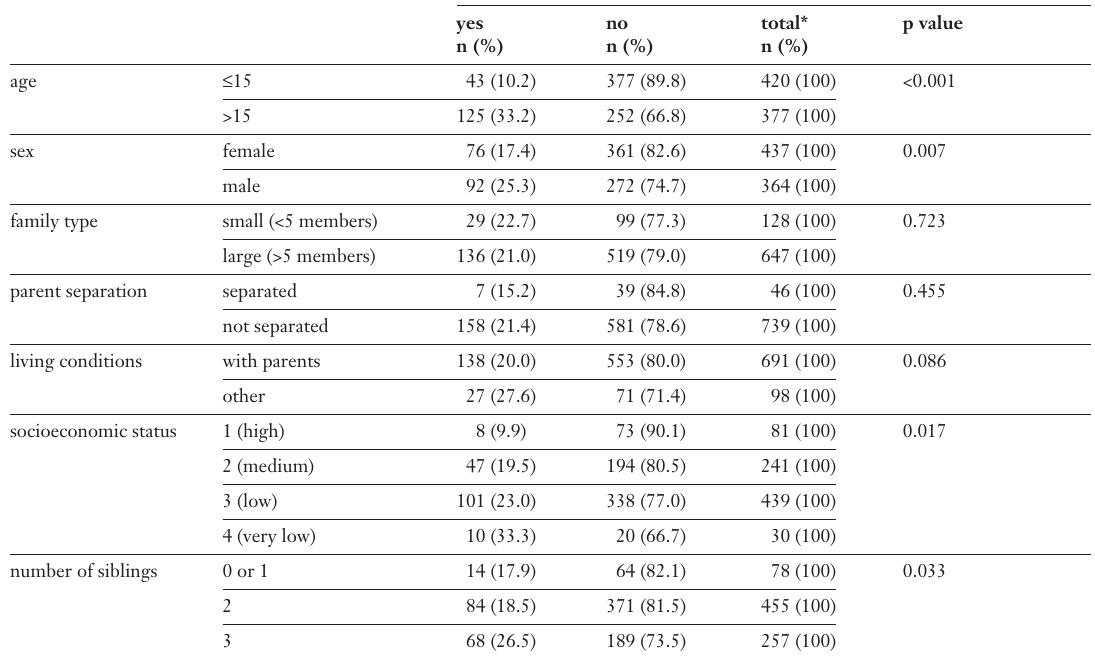
Social and demo- graphic characteris- tics of the adoles- cents with regard to smoking status.